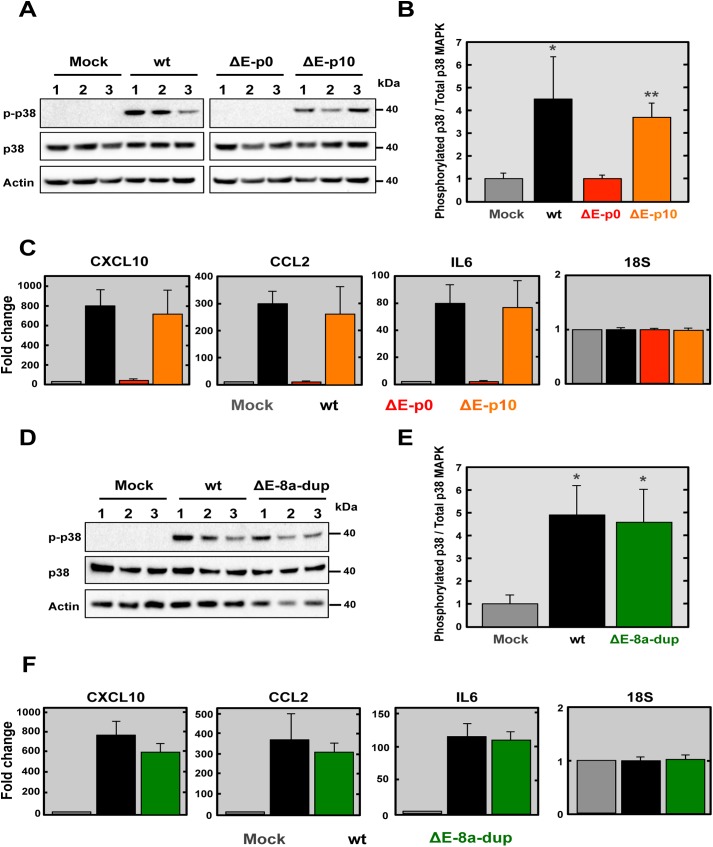
Analysis of p38 MAPK activation and inflammatory cytokines expression during infection with recombinant SARS-CoV-∆E virus after passage in mice.(A) Vero E6 cells were mock-infected or infected with the wt, ∆E and ∆E-8a-dup viruses at a moi of 0.3 and the presence of active phosphorylated (p-p38) and total (p38) p38 MAPK was detected by Western blot analysis at 24 hpi. Actin was used as control. Lines 1, 2 and 3 indicated three independent experiments analyzed in each case. (B) Phospho and total p38 MAPK amounts were quantified by densitometric analysis. The graph shows the phosphorylated p38/total p38 MAPK ratio in Vero E6 cells infected with wt, ΔE and ∆E-8a-dup viruses at 24 hpi. Statistically significant data compared to mock-infected cells are indicated with one (P < 0.05) or two (P < 0.01) asterisks. (C) Expression of inflammatory cytokines in lungs of infected mice evaluated by RT-qPCR at 2 dpi. Three independent experiments were analyzed with similar results in all cases. Error bars represent the means of three experiments analyzed for each condition. (D) Vero E6 cells were mock-infected or infected with the wt or ∆E-8a-dup viruses at a moi of 0.3 and the presence of active phosphorylated (p-p38) and total (p38) p38 MAPK was detected by Western blot analysis at 24 hpi. Actin was used as control. Lines 1, 2 and 3 indicated three independent experiments analyzed in each case. (E) Phospho and total p38 MAPK amounts were quantified by densitometric analysis. The graph shows the phosphorylated p38/total p38 MAPK ratio in Vero E6 cells infected with wt and ∆E-8a-dup viruses at 24 hpi. Statistically significant data compared to mock-infected cells are indicated with one (P < 0.05) asterisk. (F) Expression of inflammatory cytokines in lungs of infected mice evaluated by RT-qPCR at 2 dpi. Three independent experiments were analyzed with similar results in all cases. Error bars represent the means of three experiments analyzed for each condition.